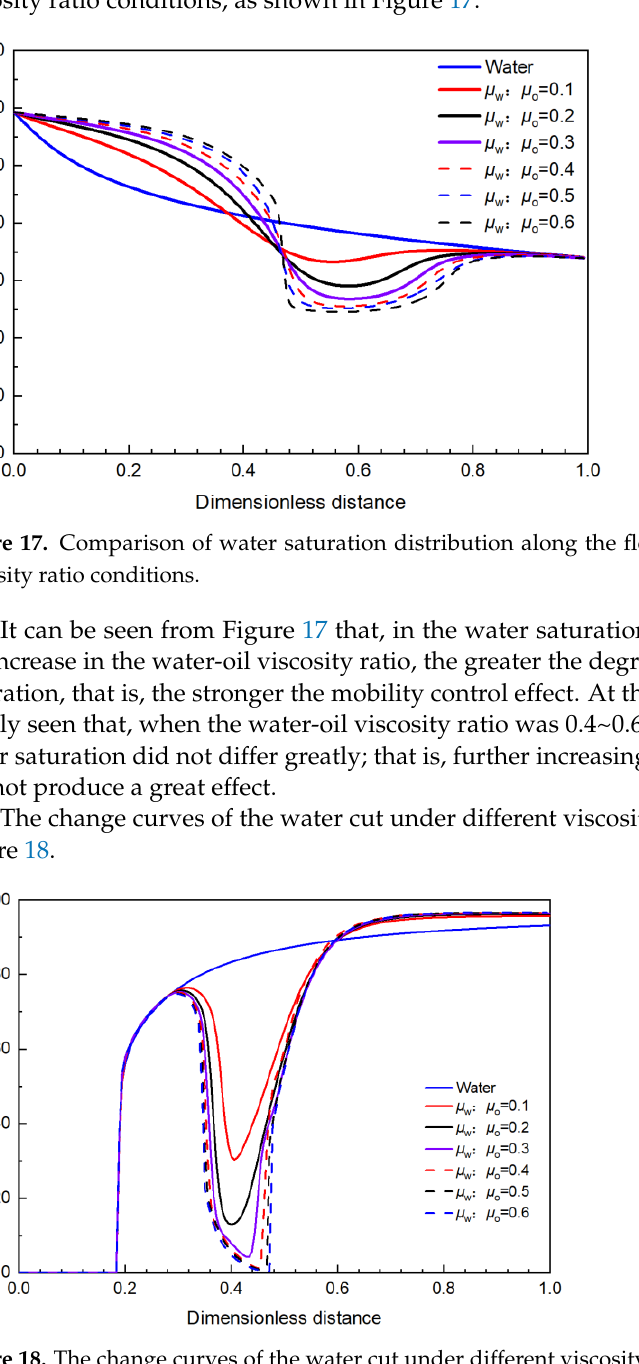
Figure 18. The change curves of the water cut under different viscosity conditions.